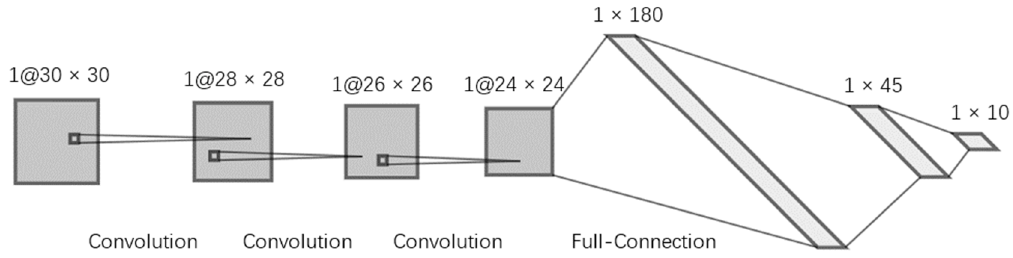
Figure 3. LeNet-3.3 network model.